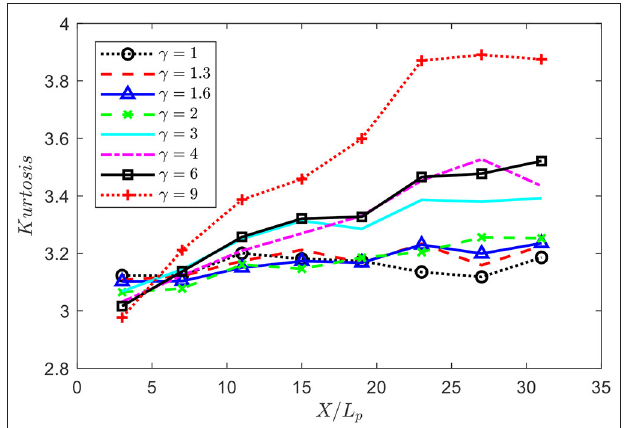
FIGURE 4 | Kurtosis along the center line of the domain Y different bandwidth.